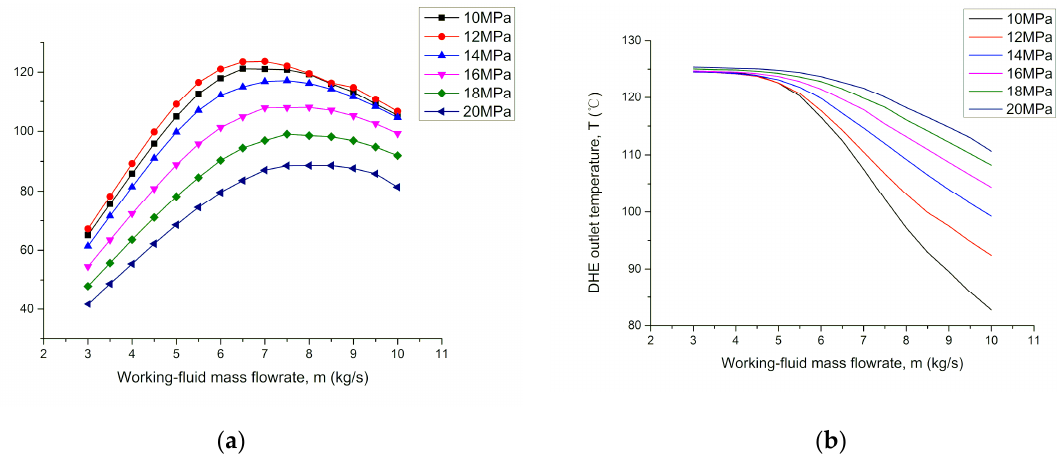
Figure 3. Effect of working-fluid’s DHE inlet pressure on net power output ( a ), and on working- fluid’s DHE outlet temperature ( b ) with respect to the change of the working-fluid’s mass flowrate (mass fraction of R32/CO 2 = 0.5/0.5, geofluid mass flowrate = 5 kg/s, geofluid temperature = 130 °C, DHE length = 300 m).